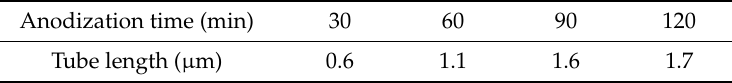
Figure 5. Side view FESEM images of TNTs at the same magnification (×50,000) synthesized at anodization time of ( a ) 30 min ( b ) 60 min ( c) 90 min and ( d ) 120 min. Table 2. Tube length as a function of anodization